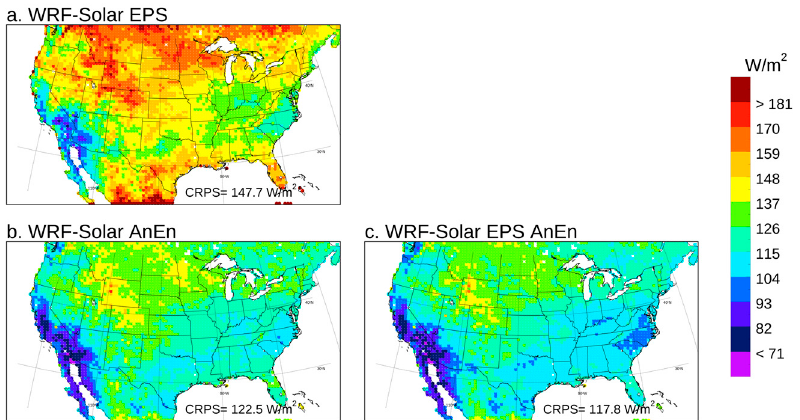
Figure A6. Continuous ranked probability score (CRPS) map computed for DNI by pooling runs and the forecast lead times from +24 to +48 h for 2018 together.